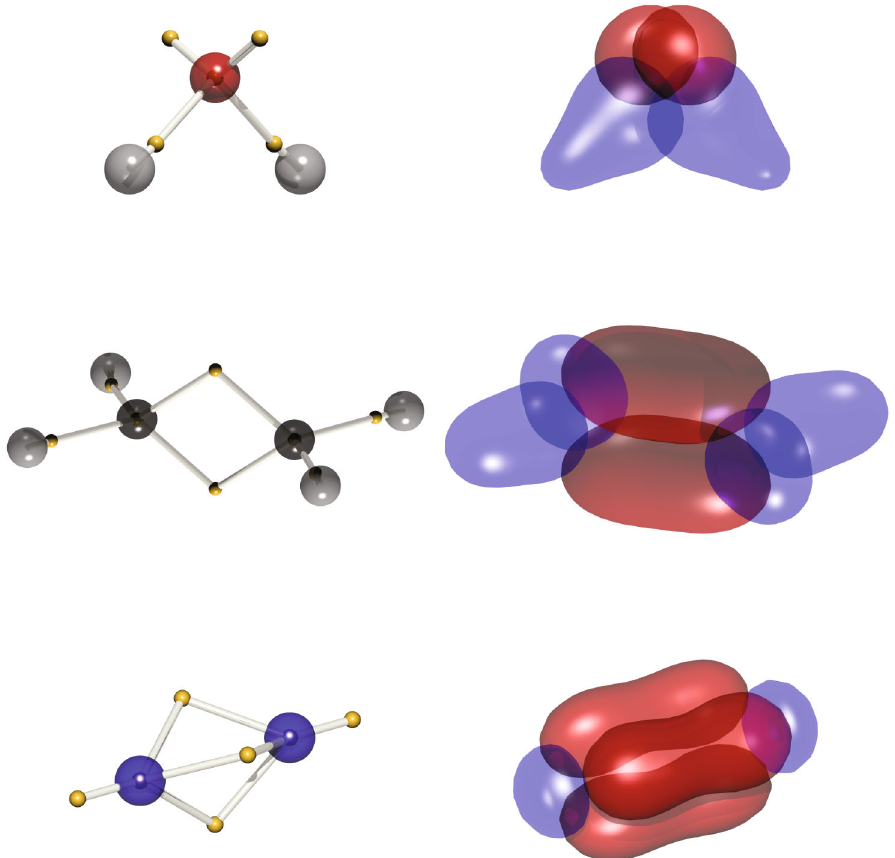
Fig. 1 Representations of electronic structure calculated by DVMS. (Left) The RHF/6-31G(d) DVMS structures of (from top) water, ethylene and dinitrogen. The gold spheres represent the average positions of electrons in the wavefunction tile. Atomic positions are given as spheres coloured according to the CPK convention. Silver rods are drawn to join nuclear positions and electron positions. (Right) Isosurfaces for each valence electron, where the positions of all other electrons are held fi xed at the positions indicated on the left. Blue and red colours are used to differentiate valence electrons of each type within a given